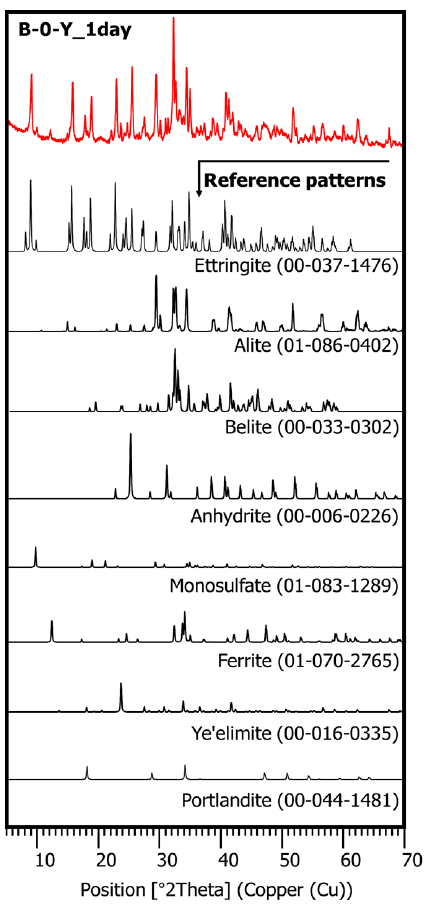
Figure 7. The integrated XRD pattern for mixture B-0-Y at 1 day.